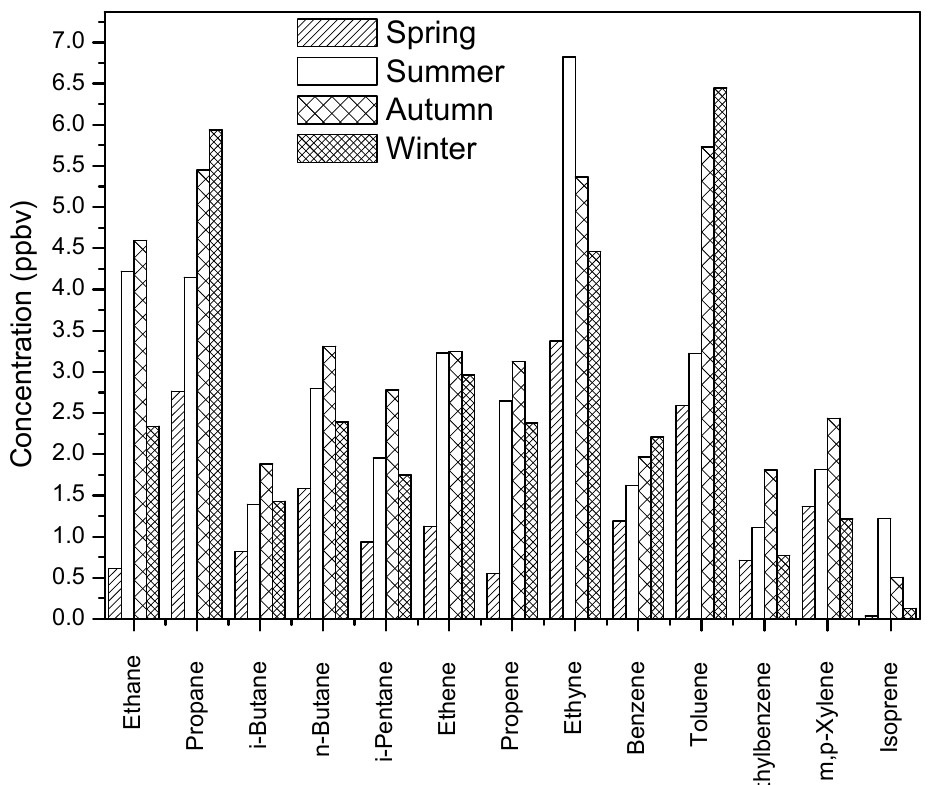
Figure 3. Seasonal variations of selected NMHCs in